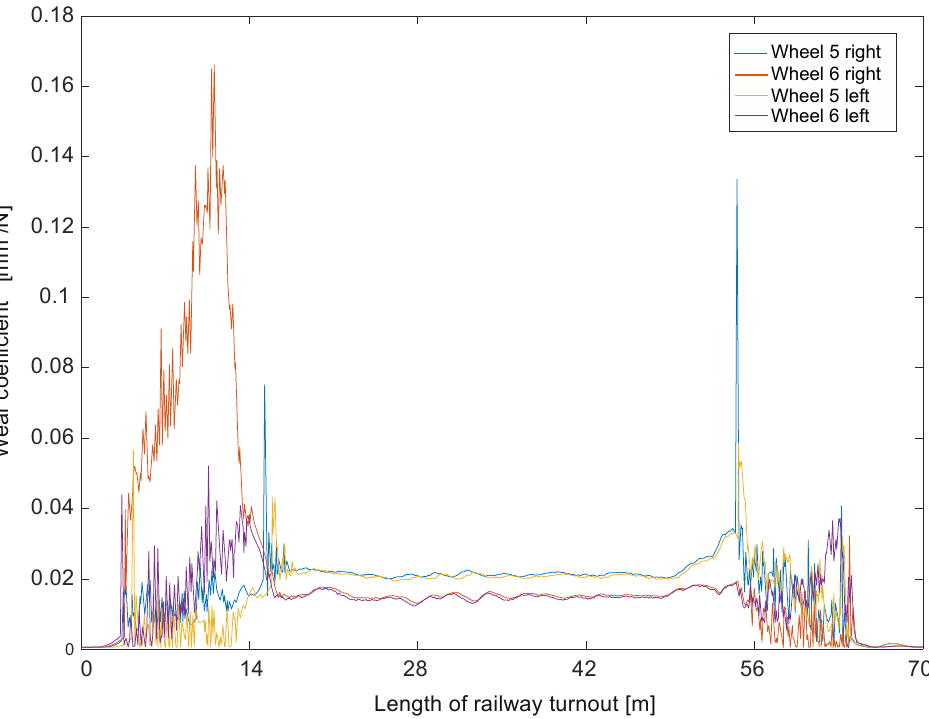
Figure 28. Wear coefficient at 100 km/h on a straight track with a turnout.